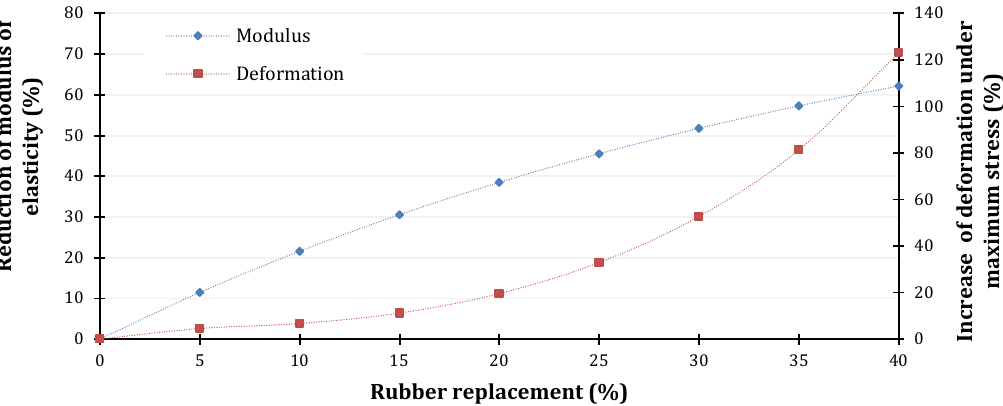
Figure 14. Variation of modulus of elasticity and maximum stress deformation for rubberized concrete.